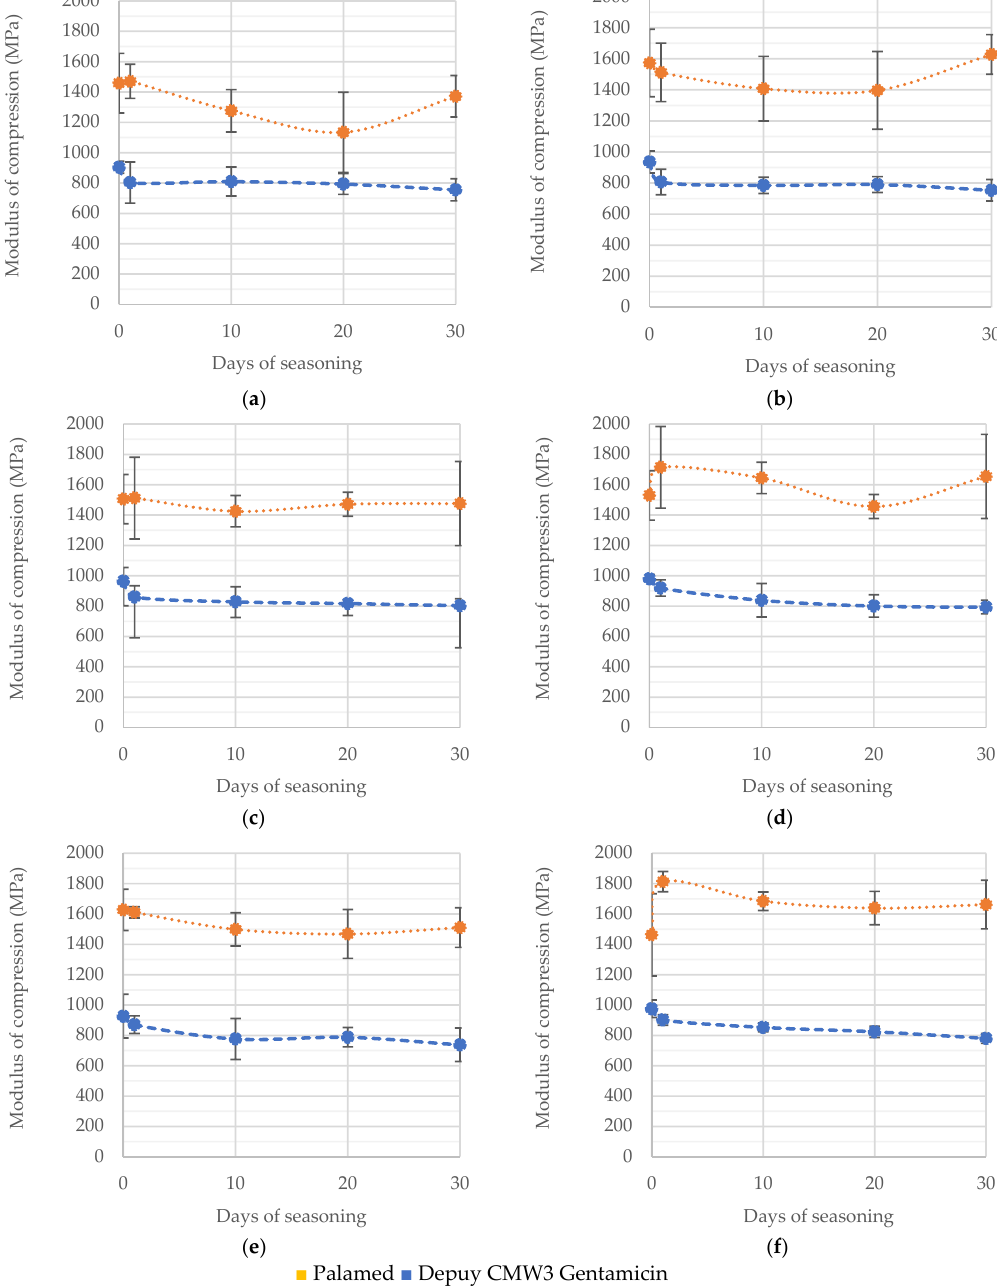
Figure 7. Variation of the average compressive modulus of the tested cements as a function of composition, i.e., ( a ) at − 30% liquid part (l.p.), ( b ) − 15%, ( c ) correct ratio, ( d ) +10% l.p., ( e ) +20% l.p., ( f ) +40% l.p.